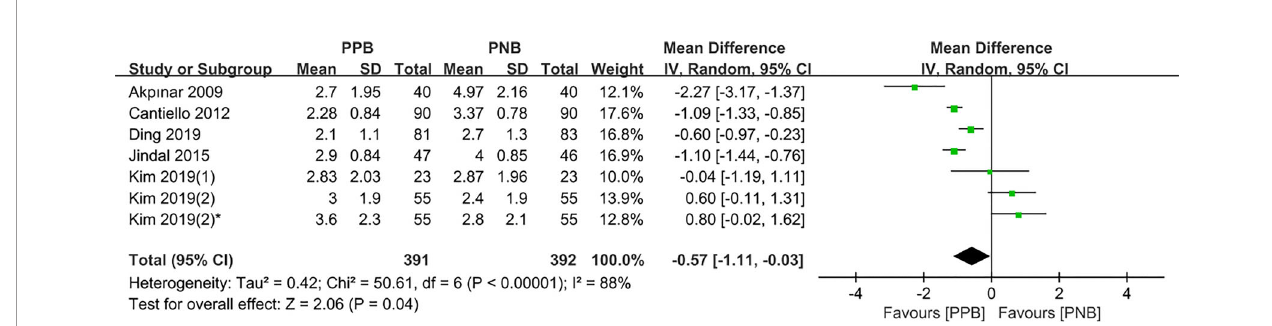
FIGURE 4 | Forest plot comparing VAS score-during biopsy in patients receiving PPB vs PNB.